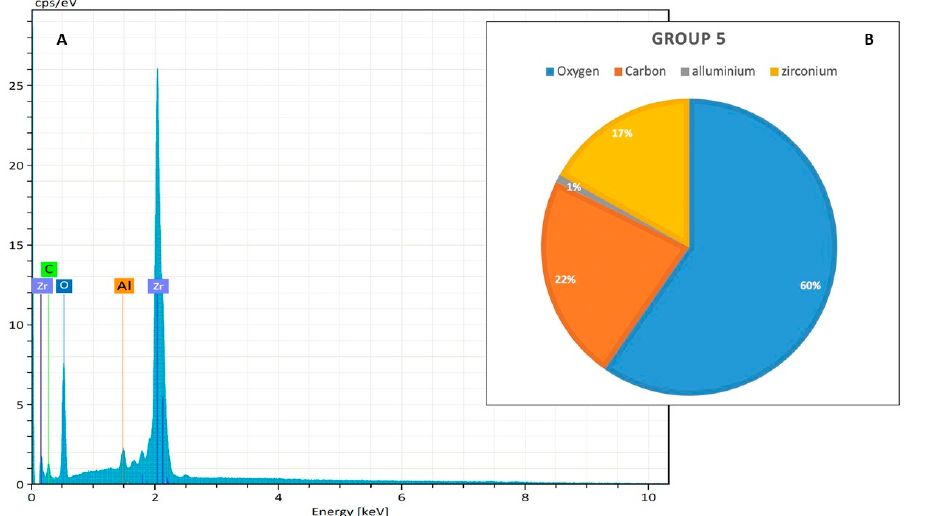
Figure 4. ( A ) The superficial composition of new SS drills without any treatment, by Energy- Dispersive X-ray Spectroscopy (EDX) analysis (keV= kilo-electron-volt, accelerating voltage range used for EDX analysis; cps/eV: counts per second per electron-volt). ( B ) The atomic percentage (%), analysis; cps / eV: counts per second per electron-volt). ( B ) The atomic percentage (%), that represent the that represent the % concentration of each element on the same sample. % concentration of each element on the same